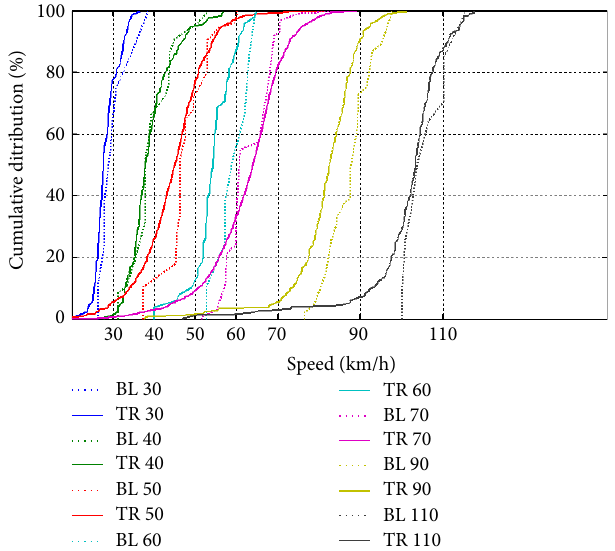
Figure 4: Distributions of desired speeds (cruising and free-driving speed) for the cases without (BL) and with (TR) the